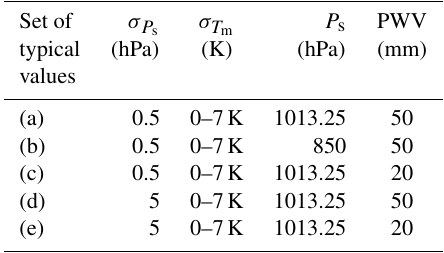
Table 4. Different typical values for σ P Set